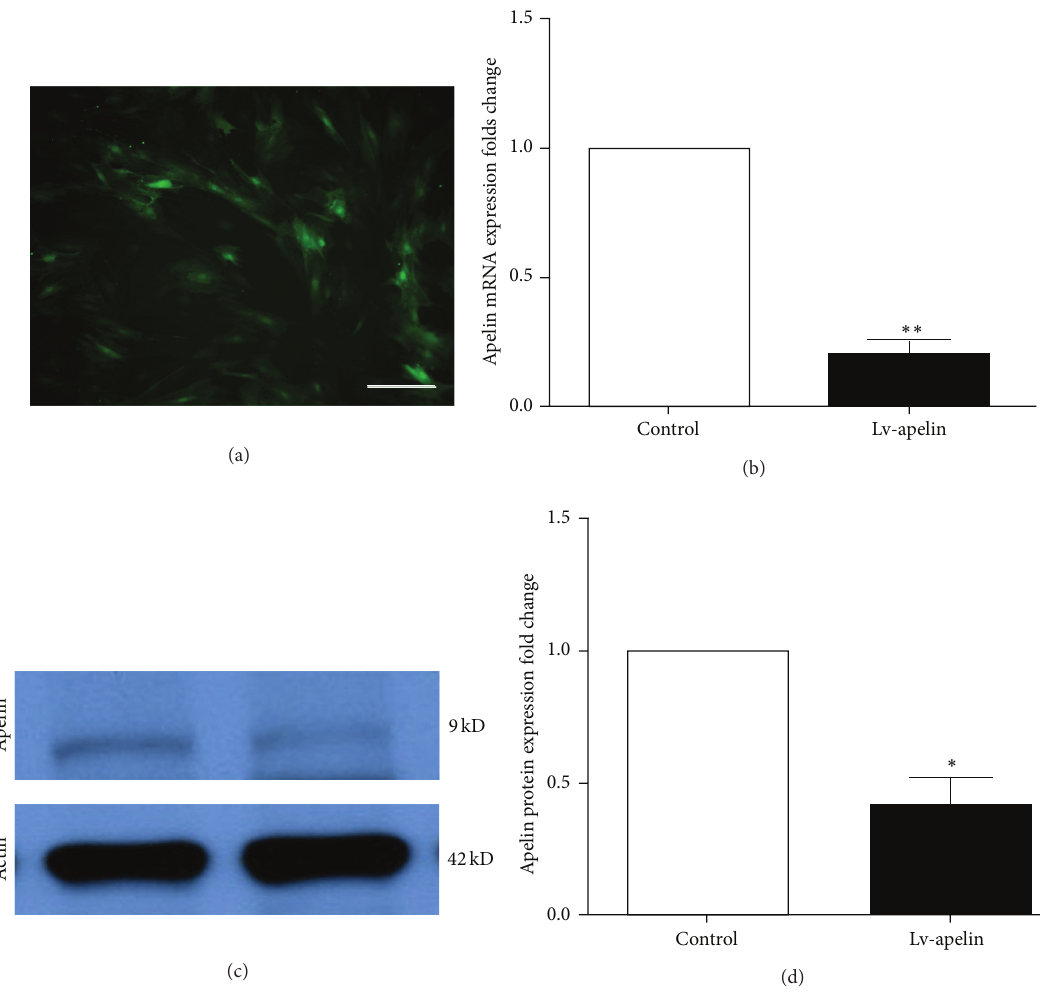
Figure 4: Pericytes transducted with Lentivirus-Apelin. (a) Immunofluorescence staining of LV-apelin infection in pericyte. Interference efficacy arrived about 90%, MOI = 100. Scale bar = 100 𝜇 m. (b) The mRNA expression of LV-Apelin was decreased by 75% after blocking by siRNA sequence ( 𝑃 < 0.01 ). (c and d). The western blot analysis shows that protein of expression of LV-Apelin decreased by 64% ( 𝑃 < 0.05